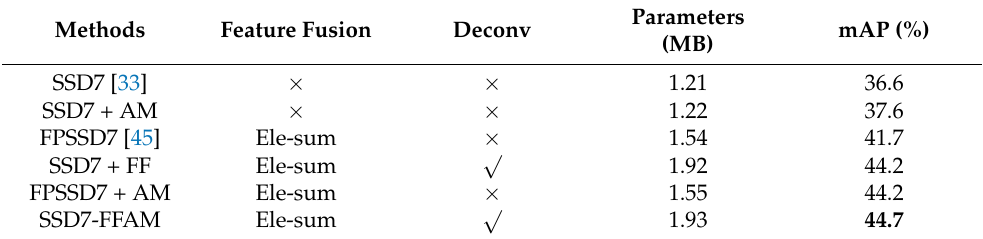
Table 2. Effects of the feature fusion module and the attention mechanism module on the SSD7. FF indicates feature fusion module; AM indicates attention mechanism module, Deconv indicates deconvolution module.